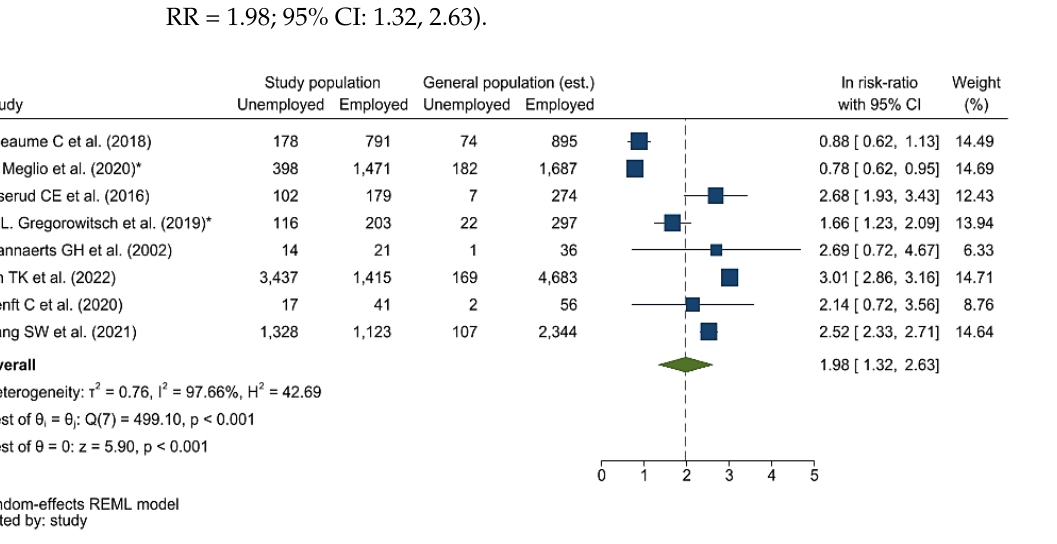
Figure 3. Forest plot of included studies. *: population composed of women only.[12,26 – 32].